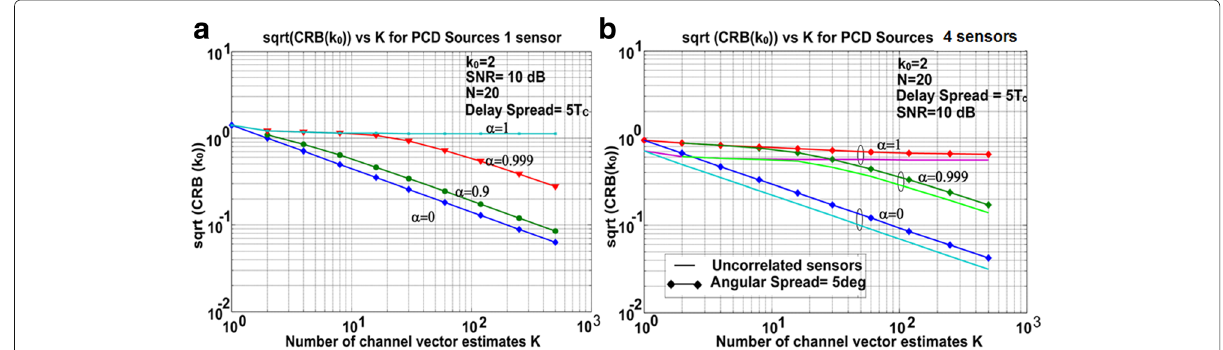
Fig. 7 CRB of k 0 as a function of the number of channel vector estimates K . Results are provided for different values of the temporal correlation coefficient α , SNR = 10 dB, and a delay spread of 5 T c . a Left: one sensor. b Right: four sensors and two possible scenarios: uncorrelated sensors case and a low angular spread case (angular spread of